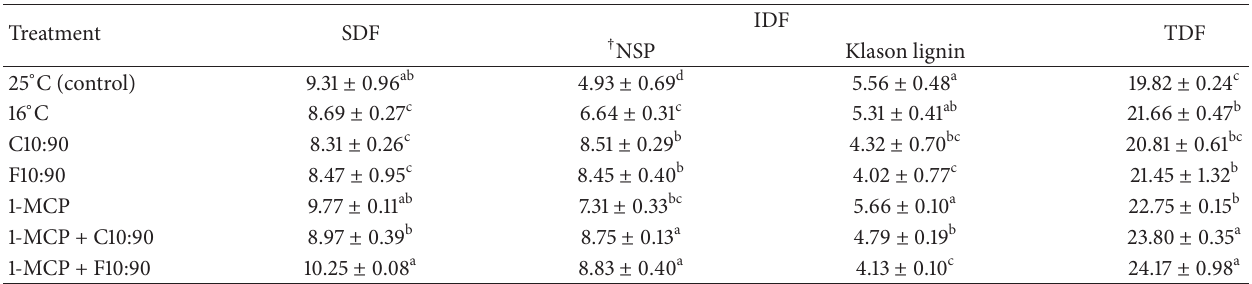
Table 2: Soluble (SDF), insoluble (IDF), and total dietary fiber (TDF) of seedless pulp obtained from soursop stored at 25 ∘ C, 16 ∘ C, fruits with emulsions and stored at 16 ∘ C; fruits treated with 1-MCP and stored at 16 ∘ C; fruits treated with 1-MCP + emulsions and stored at 16 ∘ C (g glucose/100 g dry matter of edible portion) ∗ .